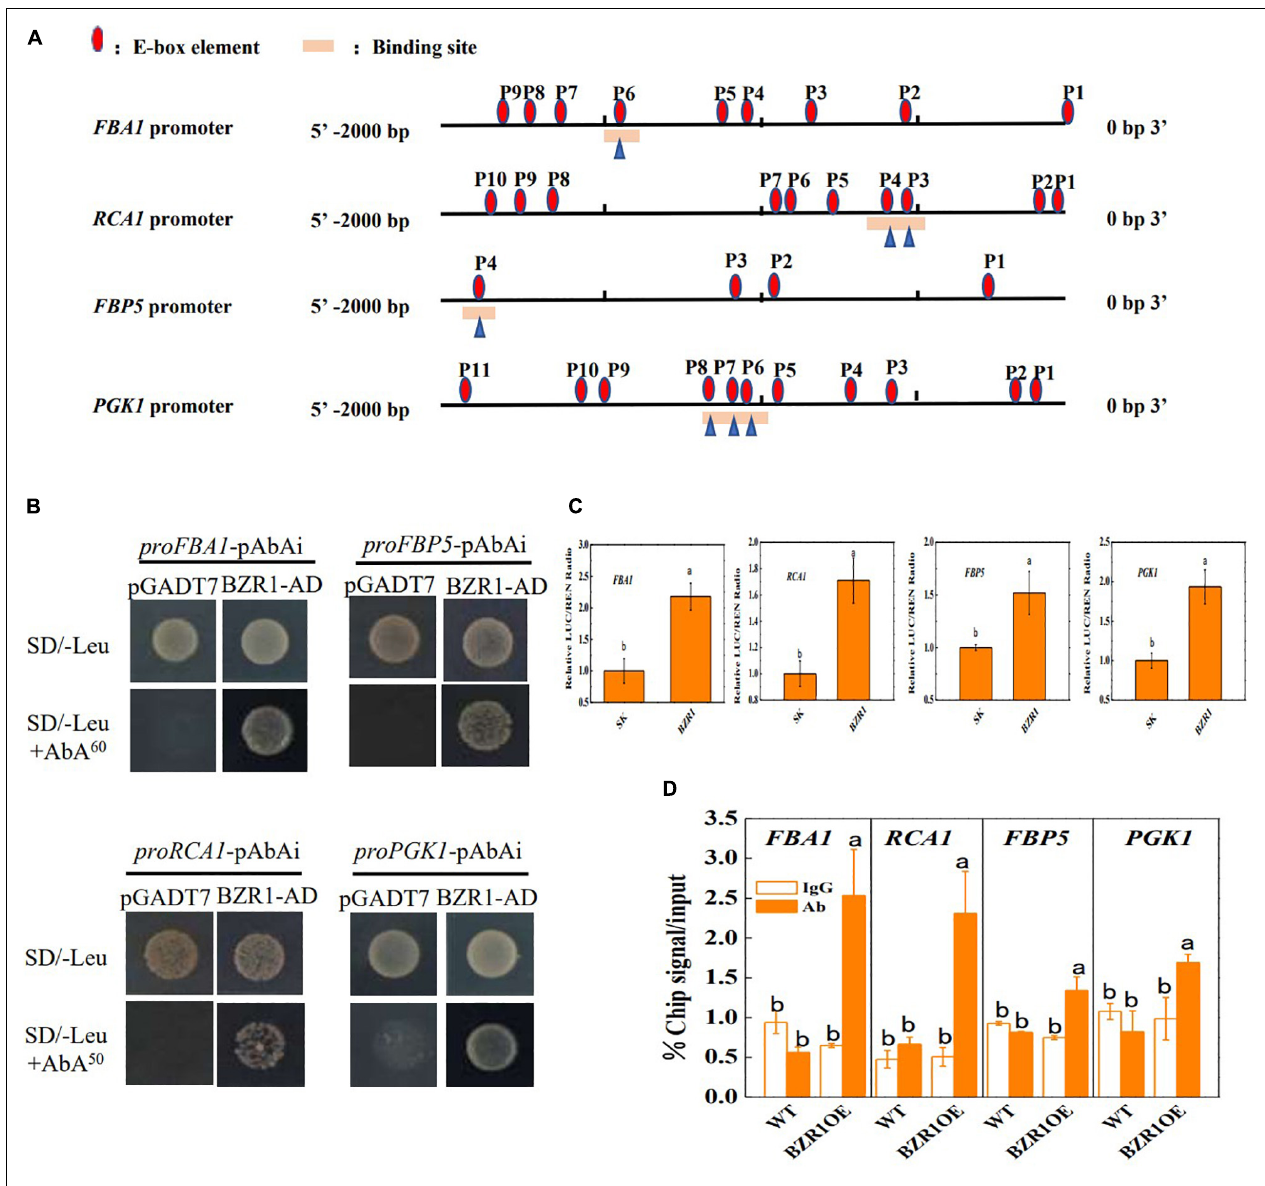
FIGURE 4 | BZR1 binds to the promoters of FBA1, RCA1, FBP5, and PGK1 in vitro and in vivo . (A) E-box elements in the promoters of FBA1, RCA1, FBP5, and PGK1 genes. The numbering is counted from the predicted transcriptional start sites. (B) Yeast one-hybrid (Y1H) experiment showing the binding of BZR1-AD to the promoters of FBA1, RCA1, FBP5, and PGK1 .Binding sites of every gene were shown in (A) . (C) Dual-luciferase assay for the regulatory effect of BZR1 on the expression of FBA1, RCA1, FBP5, and PGK1 . The ratio of LUC/REN of the combination of empty SK vectors mixed with the FBA1, RCA1, FBP5, and PGK1 promoters was set as one. (D) Direct binding of BZR1 to the promoters of FBA1, RCA1, FBP5, and PGK1 by ChIP–qPCR in 35S-BZR1-HA overexpressing ( BZR1 : OE) plants. Data present the means of three replicates ± SD. Different letters indicate significant differences ( p < 0.05) according to Tukey’s test. Three independent experiments were performed with similar